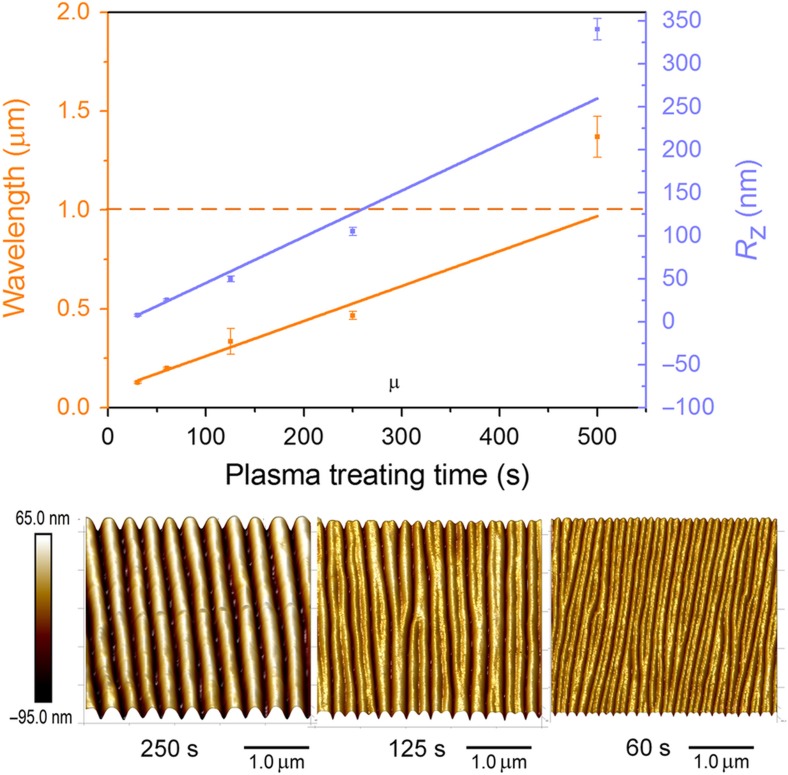
The effect of plasma-treating time on the wrinkle topology for the Solaris substrates: the wavelength, λ, and the surface roughness, Rz, as a function of the plasma-treating time; the selected AFM images of wrinkle structure with a plasma-treating time of 250, 125, and 60 s. AFM, atomic force microscopy.